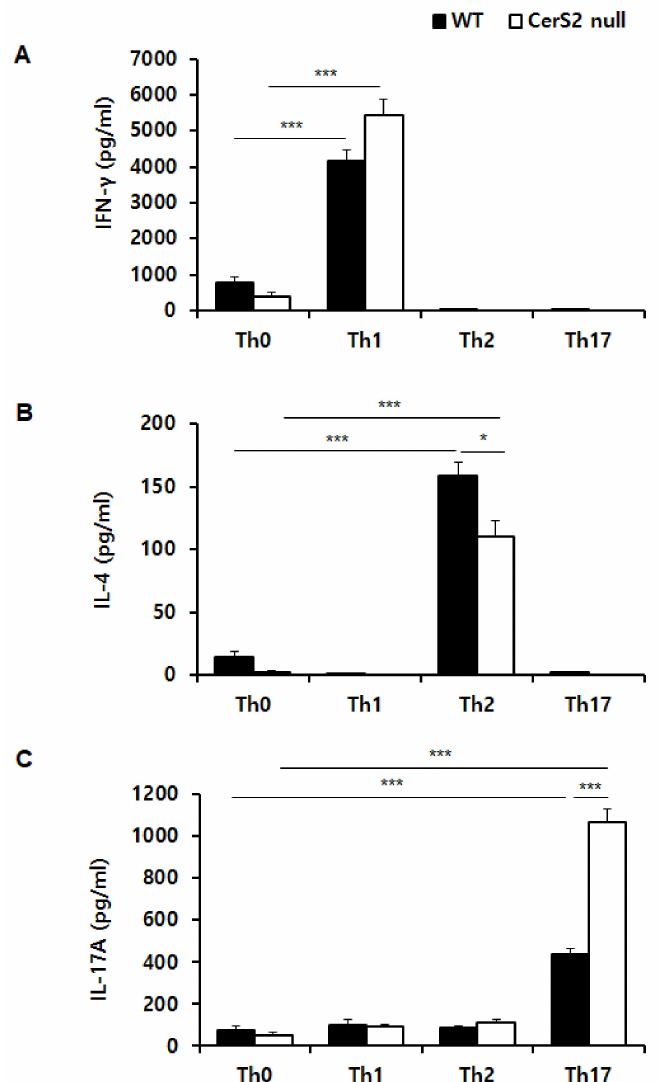
Figure 4. Helper T (Th) cells differentiate from wild type (WT)-naïve CD4+ T cells, and CerS2 null- naïve CD4+ T cells differ in cytokine secretion. Splenic naïve CD4+ T cells from WT and CerS2 null mice were differentiated into Th1, Th2, and Th17, and signature cytokines in cell culture supernatants were measured by ELISA. ( A ) WT-naïve and CerS2 null-naïve CD4+ T cells were differentiated into Th1 cells during Th1 selection conditions and exclusively produced IFN- γ . ( B ) WT-naïve and CerS2 null-naïve CD4+ T cells that differentiated into Th2 cells actively produced IL-4. CerS2 null-Th2 cells secreted significantly lower amounts of IL-4 compared with WT-Th2 cells. ( C ) WT-naïve and CerS2 null-naïve CD4+ T cells successfully produced IL-17 during Th17 polarizing stimulation. CerS2 null-Th17 cells showed significantly higher levels of IL-17 than WT-Th17 cells. Data are expressed as the mean ± SEM ( n = 4). * p < 0.05; *** p < 0.001. Statistical significance was analyzed using the two-way analysis of